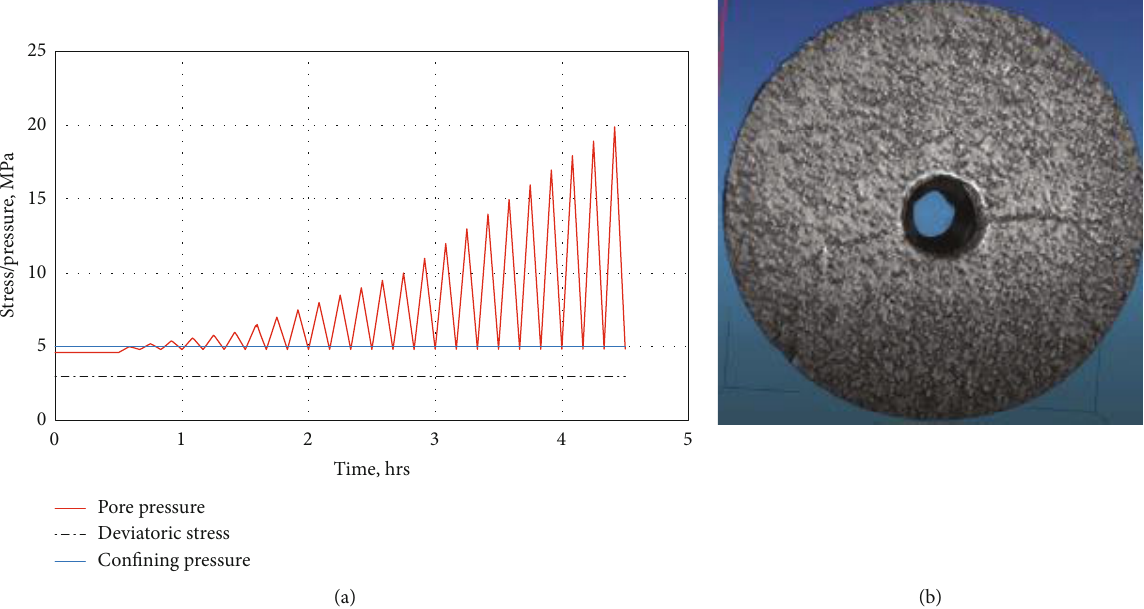
Figure 10: (a) Cyclic pressure loading, con fi ning pressure, and deviatoric stress conditions applied; (b) CT scans of the tested